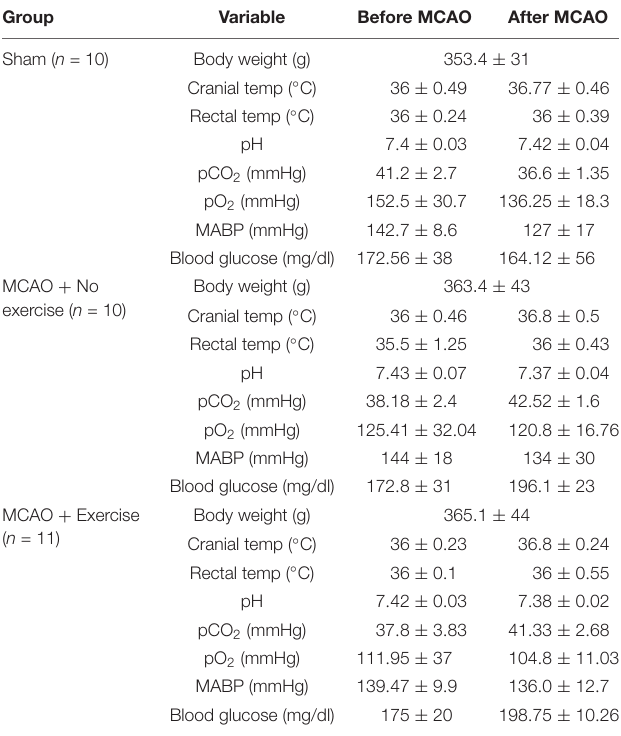
TABLE 2 | MCAO physiological parameters for female rats belonging to exercise and no exercise groups. Group Variable Before MCAO After